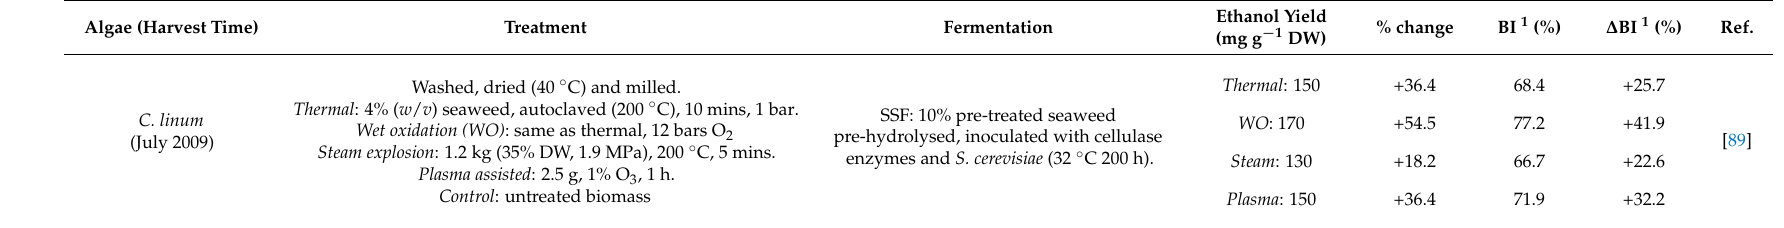
Table 5. Ethanol yields following thermal pre-treatment